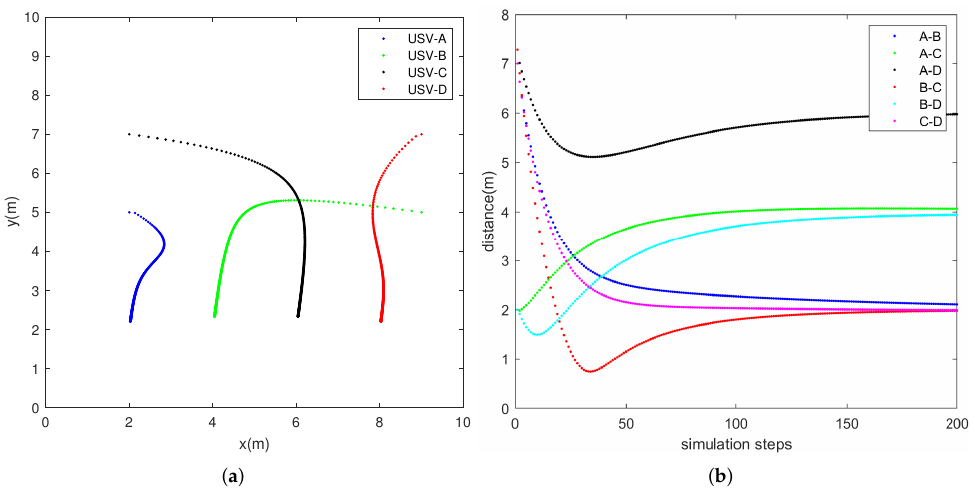
Figure 7. Data diagram of USVs formation without artificial potential field: ( a ) trajectory diagram of USVs during formation; ( b ) changes in the distance between USVs during the formation